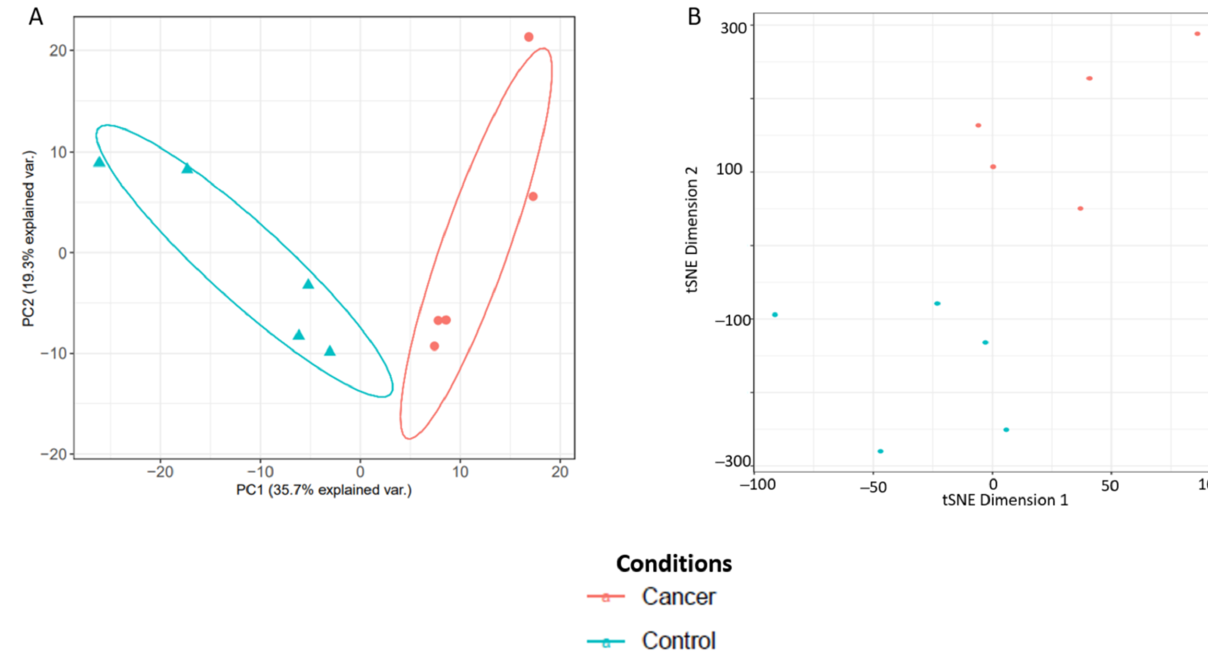
Figure 10. Analysis of sample separation comparing five EC cases and five controls using principal component analysis (PCA) ( A ) and t-distributed stochastic neighbour embedding (t-SNE) ( B ) plots based on differentially expressed cervico- vaginal fluid proteins. Table 7. Reproducibility of selected biomarker candidates using the consensus cervico-vaginal fluid spectral library. Biomarker